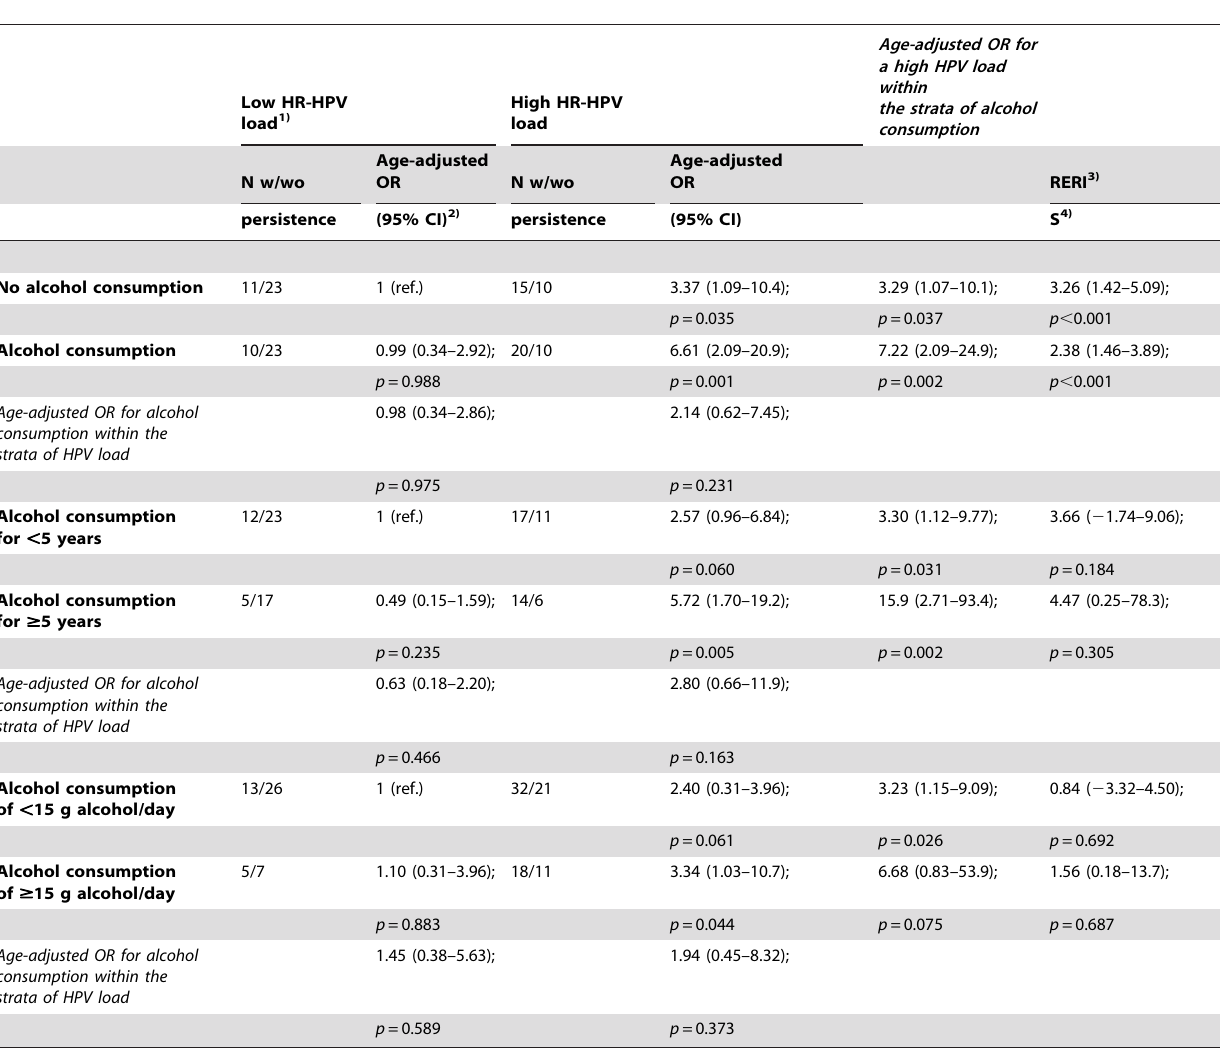
Table 5. Effect of the interaction between a high HR-HPV load and alcohol consumption on the risk of 2-year HR-HPV